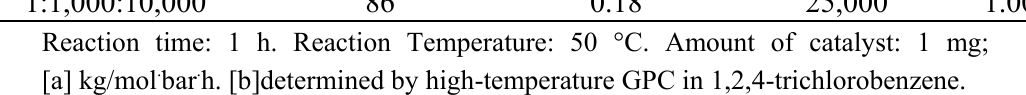
Figure 4. 1 H-NMR spectrum of poly(1-hexene) in C